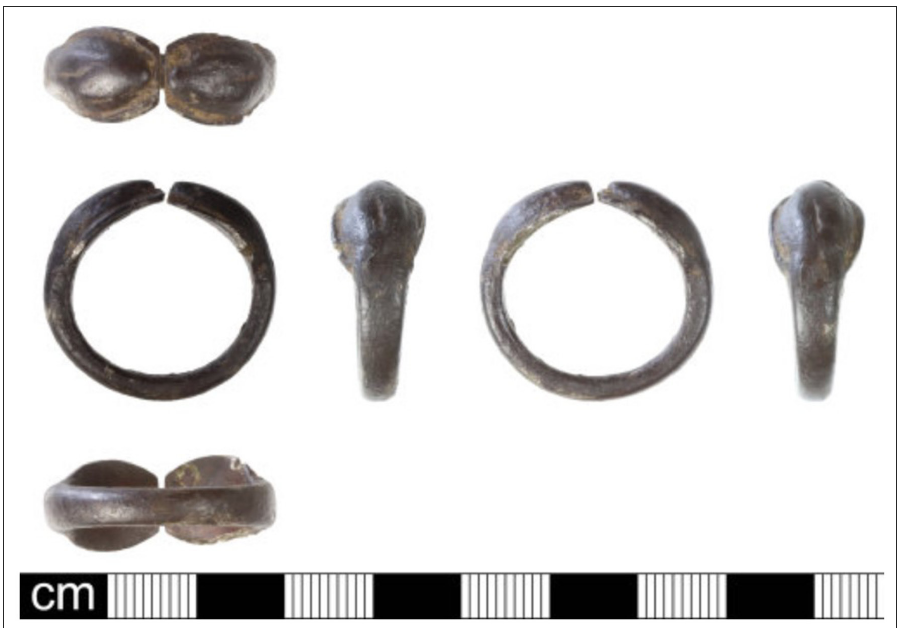
Figure 8: Snake ring (Image curtsey of the Portable Antiquities Scheme, Record ID: